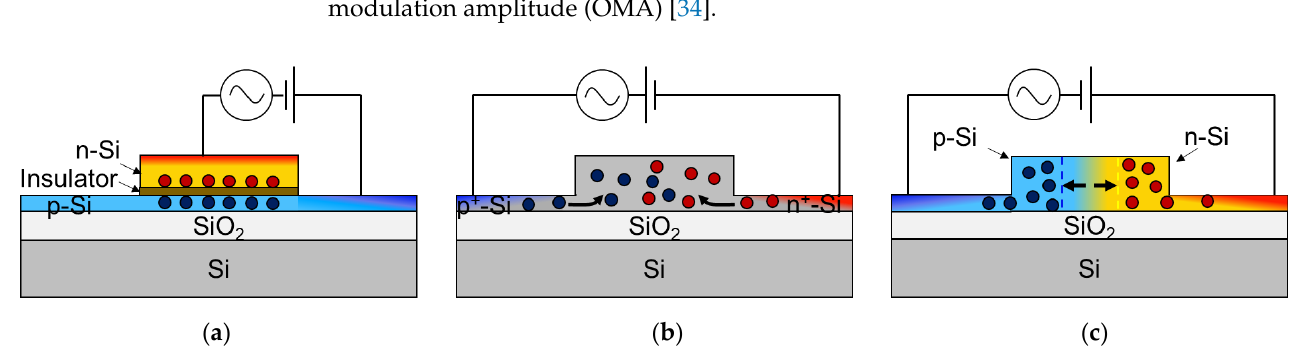
Figure 1. Cross-sections of typical device structures implementing the three different mechanisms ( a ) Carrier accumulation, ( b ) Carrier injection, and ( c ) Carrier depletion.